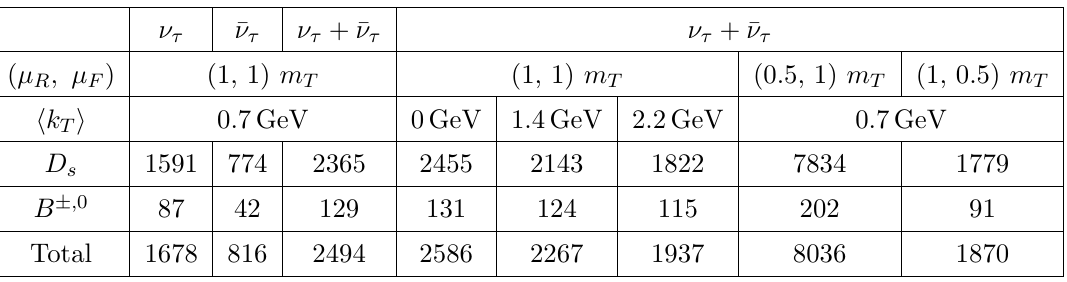
Table 2 . Same as table 1, but adopting ( (cid:22) R ; (cid:22) F ) = (1 : 0 ; 1 : 0) m T as central scales in the computation of heavy-meson hadroproduction (conventional scale choice). The scale combinations (0 : 5 ; 1) m T and (1 ; 0 : 5) m T give the upper and lower limits of the scale variation envelope from the seven combinations of ( N R ; N F ) shown in (cid:12)gure